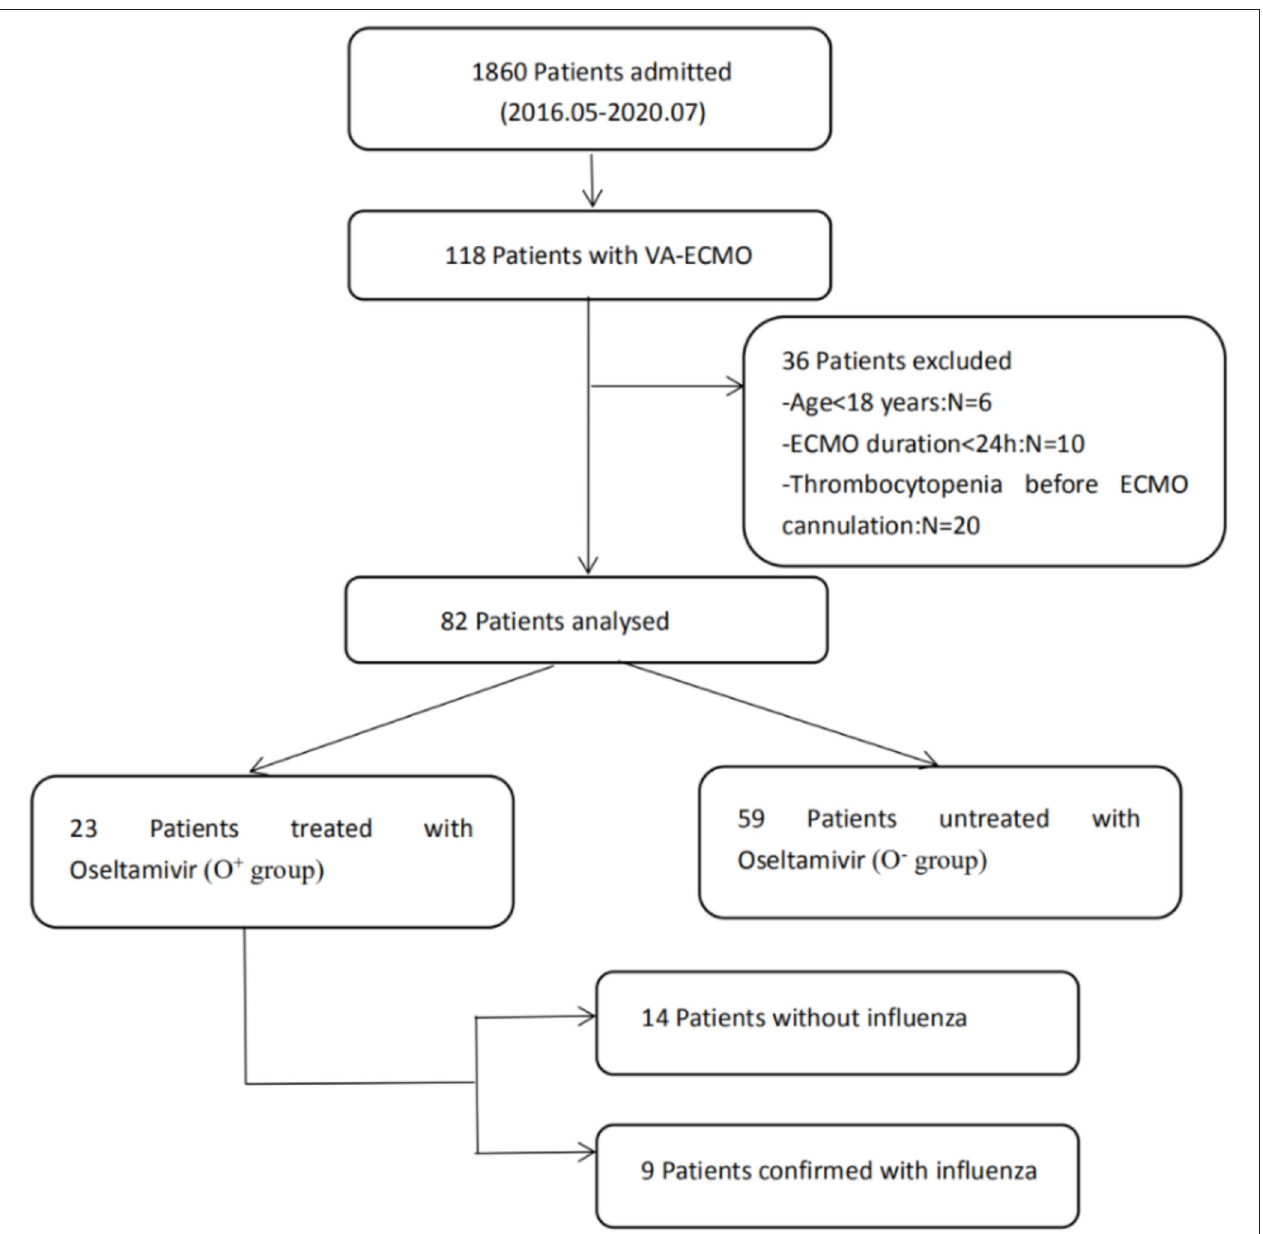
FIGURE 1 | Patient recruitment flowchart. ECMO, extracorporeal membrane oxygenation.